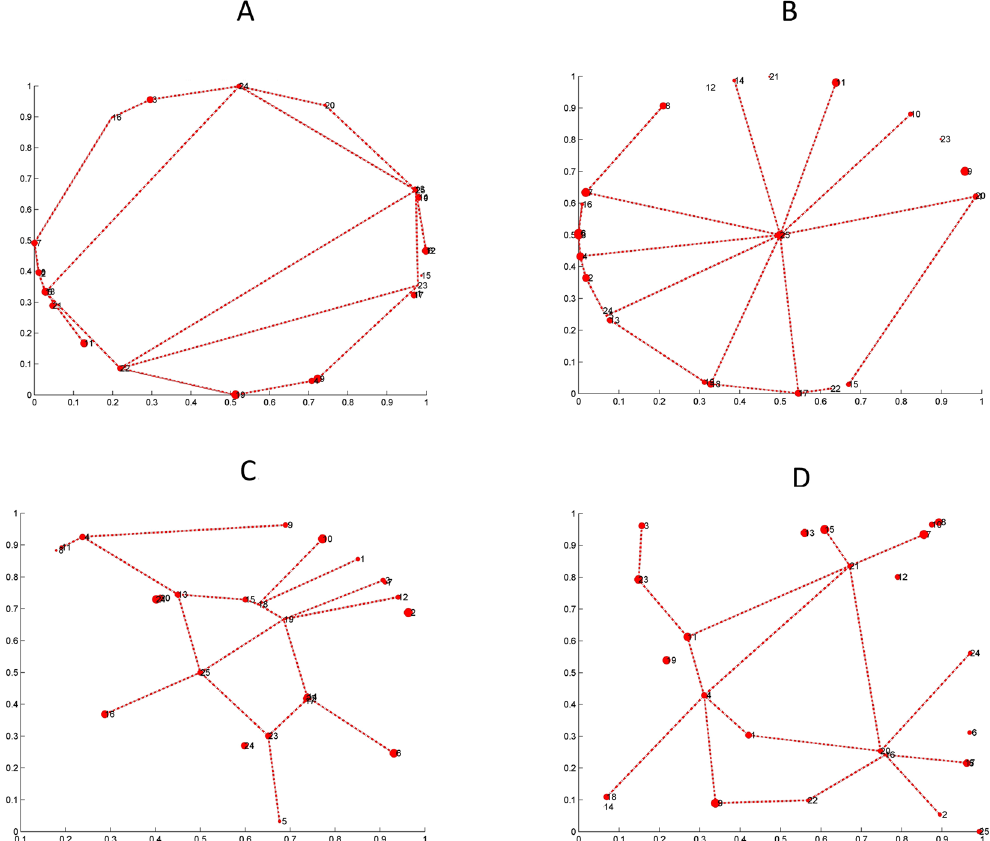
Figure 8. Snapshot of the network of improved connections among 15 towns after 18 iterations in the four geographical distributions considered starting from a Delaunay network and the type I decision